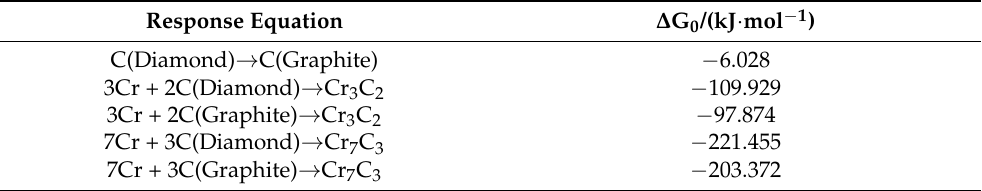
Table 2. Brazing reaction at 950 °C and its ∆ G 0